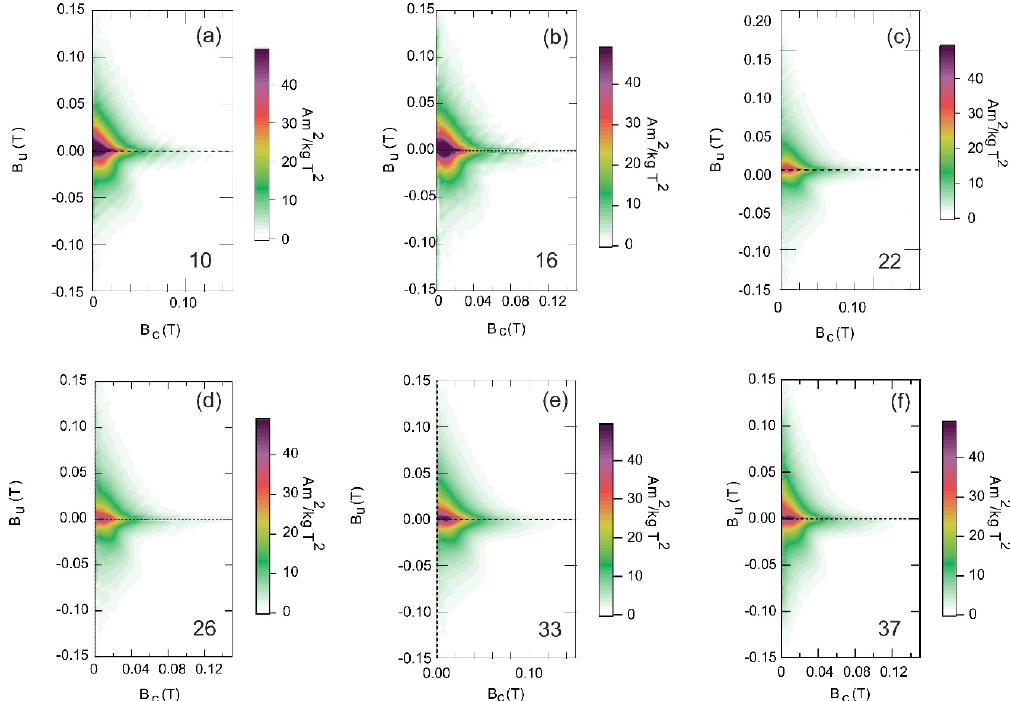
Figure 11. First-order reversal curve (FORC) diagrams for selected samples collected from areas nearby the three ironworks: T ř inec ( a , b ), Ostrowiec ( c , d ), and Katowice ( e , f ). Smoothing factors: S c 0 = 4, S b 0 = 3, S c 1 = S b 1 = 4, and λ = 0.1.